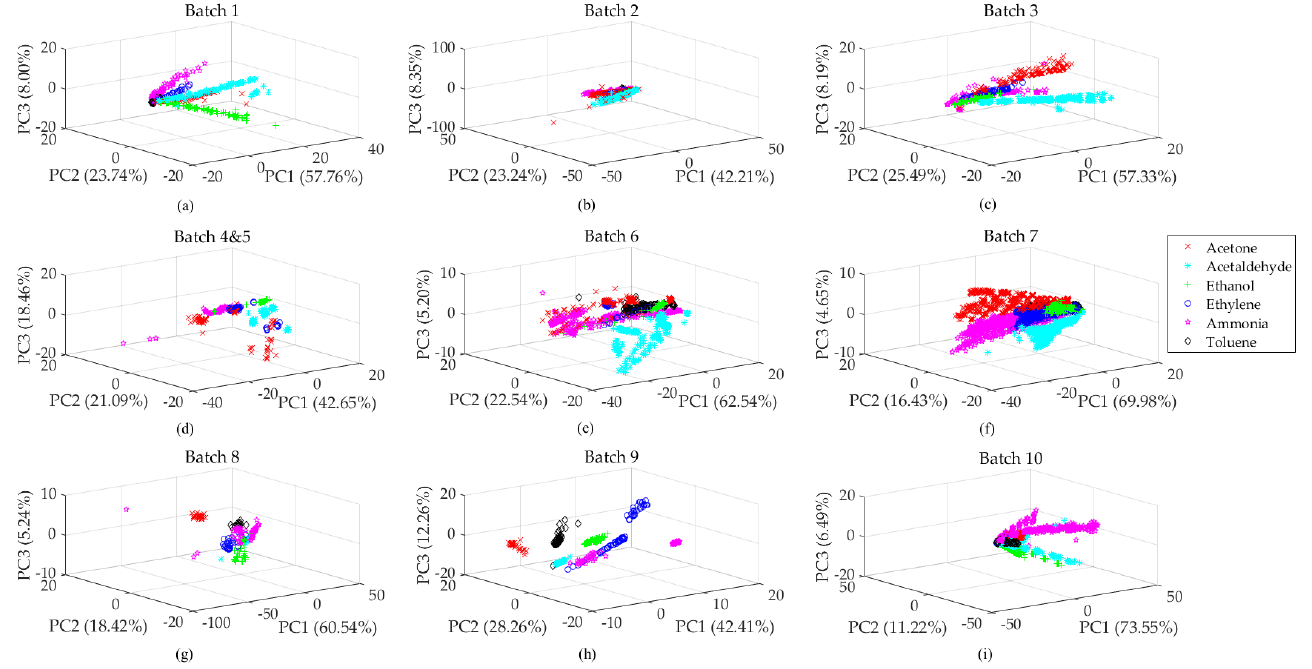
Figure 3. Data distribution of dataset A. ( a ) Distribution of batch 1, ( b ) distribution of batch 2, ( c ) distribution of batch 3, ( d ) distribution of batch 4&5, ( e ) distribution of batch 6, ( f ) distribution of batch 7, ( g ) distribution of batch 8, ( h ) distribution of batch 9, ( i ) distribution of batch 10.